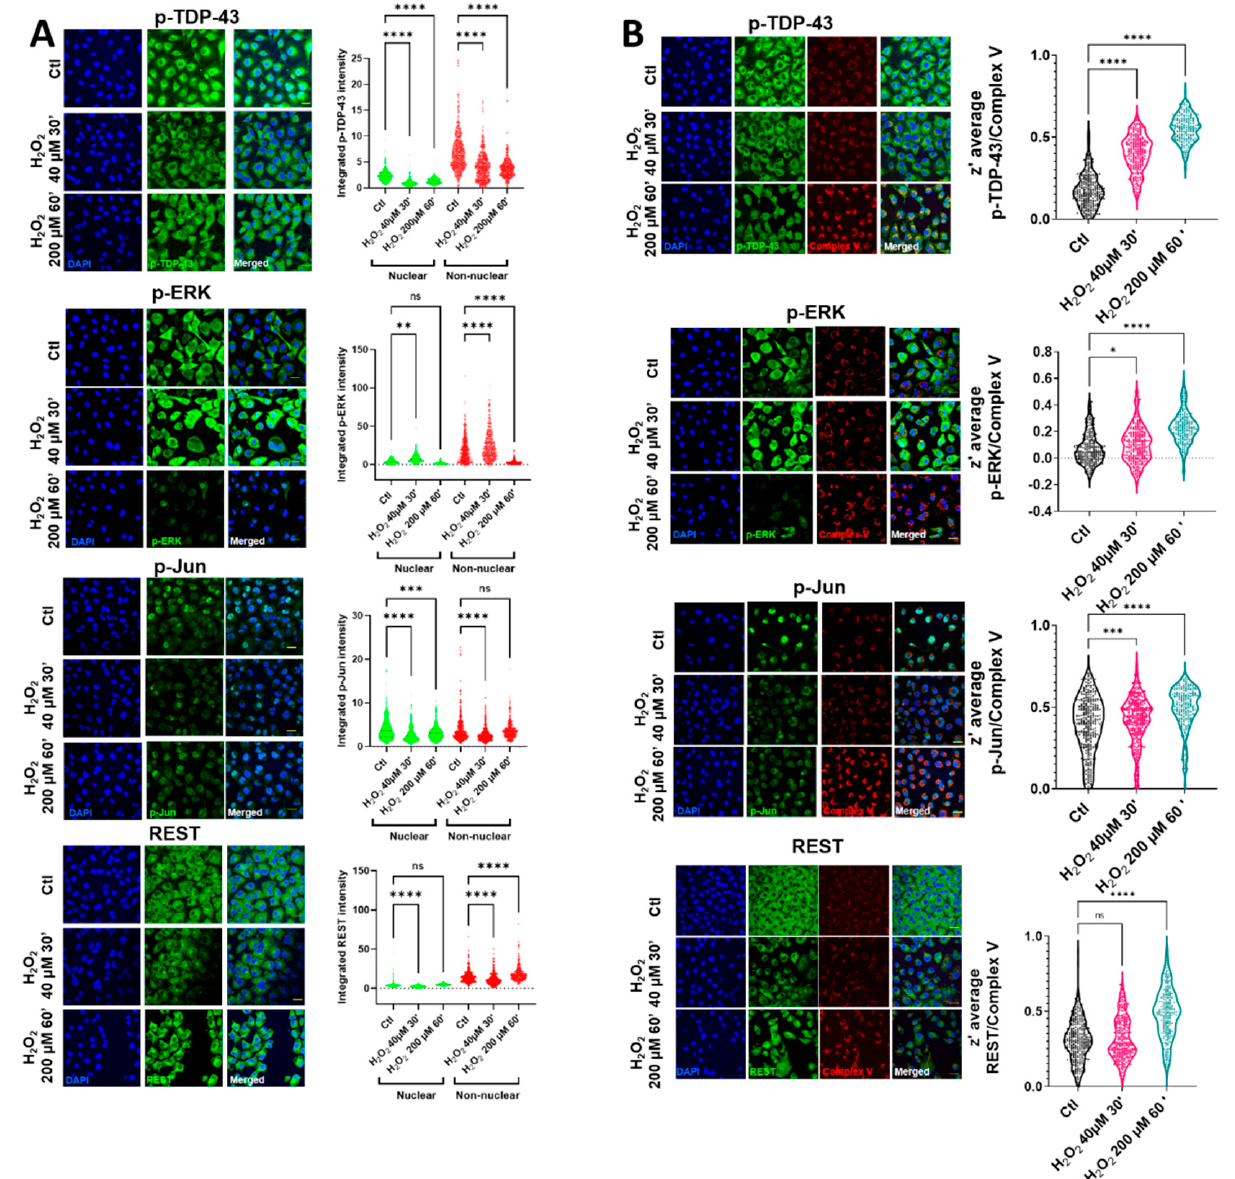
Figure 1. Oxidative stress induces changes in the levels of proteins implicated in neurodegeneration and its colocaliza- tion with mitochondrial epitopes. ( A ) Representative confocal microscopy images of HMEC cells immunostained with antibodies against p-TDP-43 (left), p-ERK (middle left), p-Jun (middle right), and REST (right), showing diverse effects of oxidative stress (H 2 O 2 , dose and time indicated) in nuclear and non-nuclear (cytosol) immunostaining (quantified below). ( B ) Representative coimmunostaining confocal microscopy images of the above-mentioned proteins, with mitochondrial epitopes (Complex V). The degree of colocalization was estimated by calculation of the z’ factor, shown in the violin graphs below. In ( A ), the bars indicate the mean with the standard deviation shown by the lines ( n = 200–296 cells for p-TDP-43, n = 191–255 for p-ERK, n = 234–326 for p-Jun, and n = 217–415 for REST, obtained in at least 4 independent replicates). * Indicates p < 0.05, ** p < 0.01, *** p < 0.001, and **** p < 0.0001 by Sidak’s post-hoc multiple comparison test after a 2-way ANOVA (in A ) or by Dunnett’s post-hoc multiple comparison test after an ANOVA (in B ). Bars in ( A , B ) are 60 micrometer